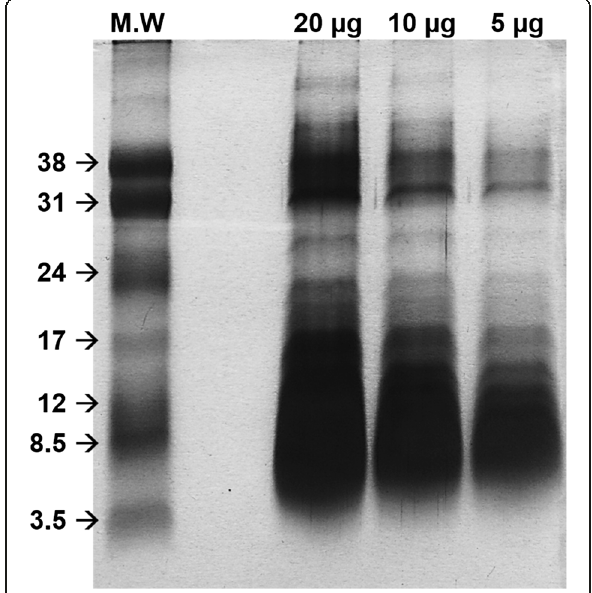
Fig. 2 SDS-PAGE 15 % of Hlsv. In lane 1, the low molecular weight marker. In the other lanes, 20, 10 and 5 μ g of Hlsv under reducing conditions. The gel was